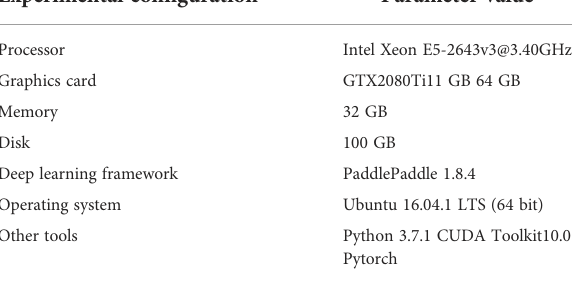
TABLE 1 Experiment con fi